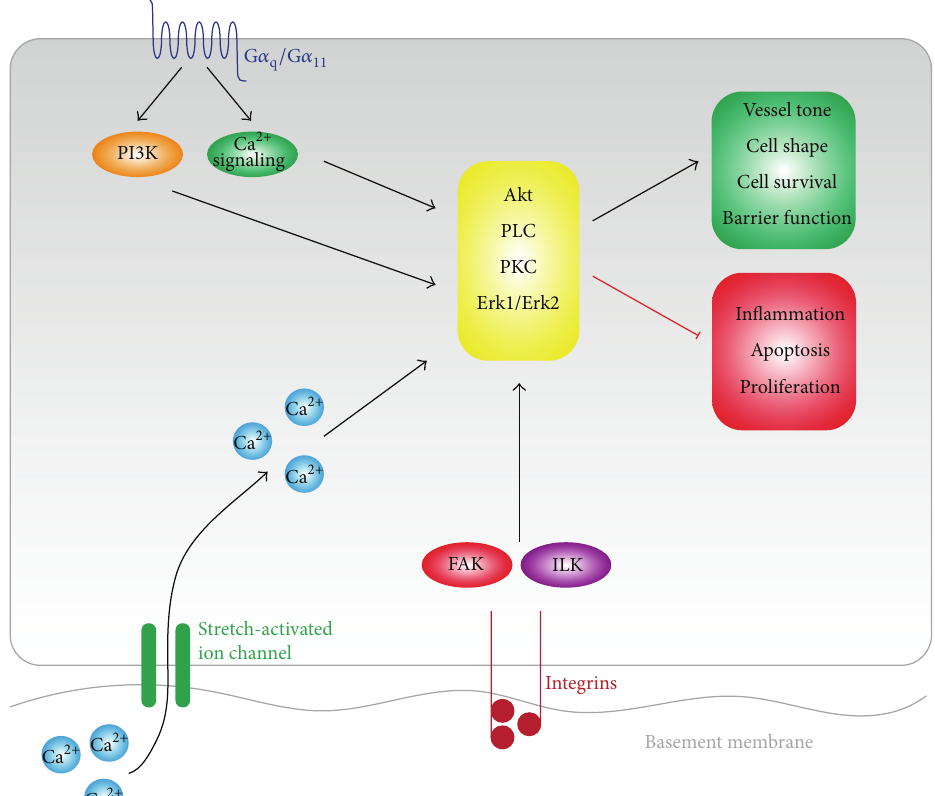
Figure 3: Endothelial cyclic strain sensing. Endothelial cells sense CS through a number of mechanisms. Stretch-sensitive ion channels undergo a conformational change during stretch which opens up the channel and induces Ca 2+ flux from the extracellular space into the endothelial cell. Basal 𝛽 1-integrins anchor to the endothelial basement membrane and activate focal adhesion kinase (FAK) and the integrin- linked kinases (ILK). The G-protein-coupled receptors of G 𝛼 q /G 𝛼 11 sense CS and activate downstream PI3K and Ca 2+ signaling. Signaling through these stretch sensors culminates in activation of Akt, PKC, PLC, and Erk1/2 which collectively maintain the endothelial